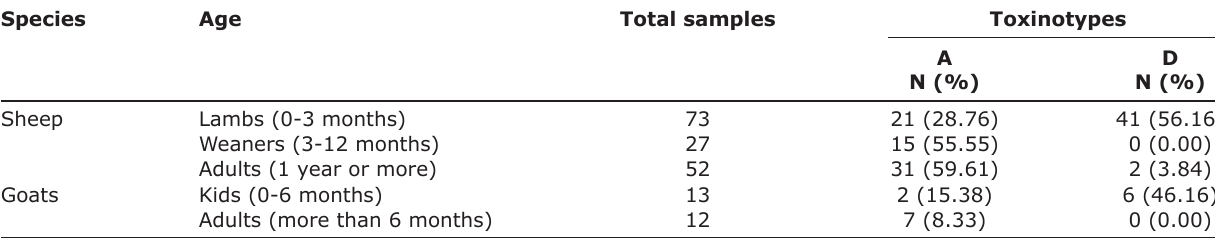
Table-5: Age-wise distribution of Clostridium perfringens toxinotypes in sheep and goats.